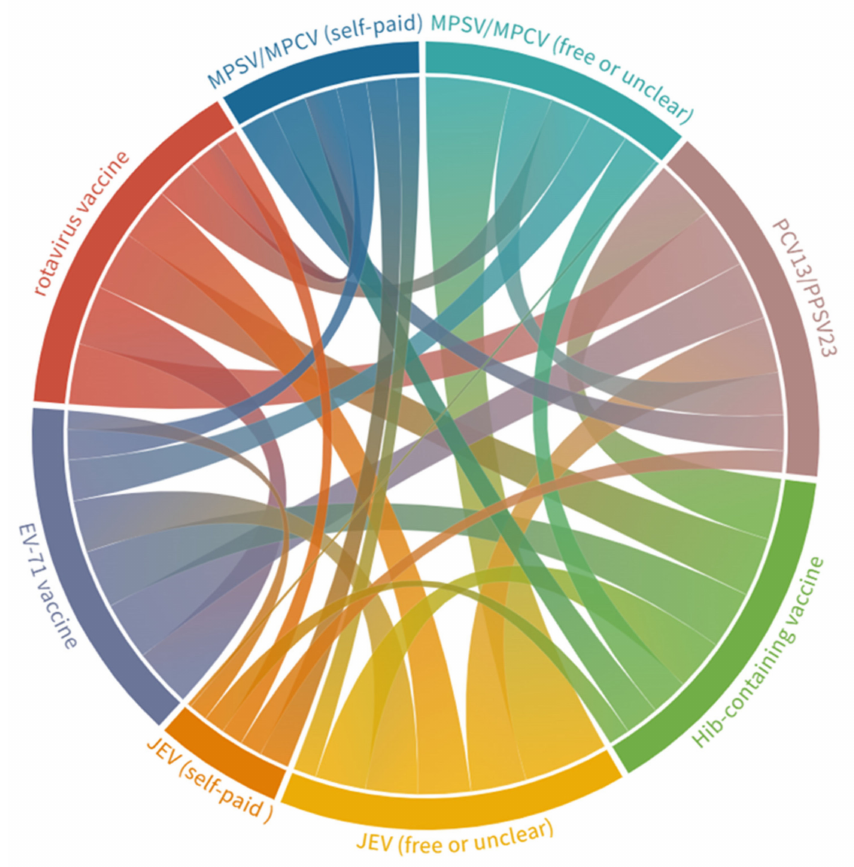
Figure 2. A chord diagram presenting the concurrent uptake of vaccines that may prevent meningi- tis/encephalitis in children. MPSV, meningococcal polysaccharide vaccine; MPCV, meningococcal polysaccharide conjugate vaccine; JEV, Japanese encephalitis vaccine; PCV13, 13-valent pneumococ- cal conjugate vaccine; PPSV23, 23-valent pneumococcal polysaccharide vaccine; Hib, Haemophilus influenzae type b; EV-71, enterovirus 71. Table 2. Knowledge of meningitis/encephalitis (M/E) and related